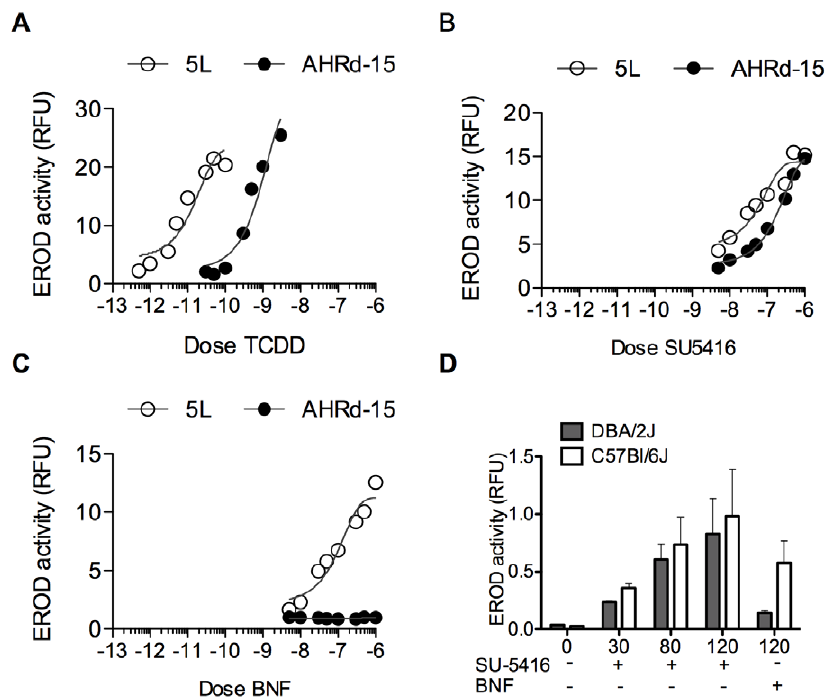
Figure 3. InVitro dose response curves. A. Rat hepatoma cell lines bearing the murine AHR d (AHR d -15) or the rat AHR b (5L) were incubated with increasing doses of TCDD in 96-well plates. After 40 hours, EROD activity was performed from whole cell lysate. (n=3). B. Same assay as in A, with increasing doses of SU5416. (n=3). C. Same assay as in A, with increasing doses of BNF. (n=2). D. Male DBA/2J and C57BL/6J mice (6 weeks old) were orally administered 120 mg/kg BNF, the indicated doses of SU5416 or the vehicle corn oil. Following 48 hours, hepatic microsomal proteins were isolated and used for the assessment of EROD activity. Animals were treated in groups of 4. Error bars: S.D.